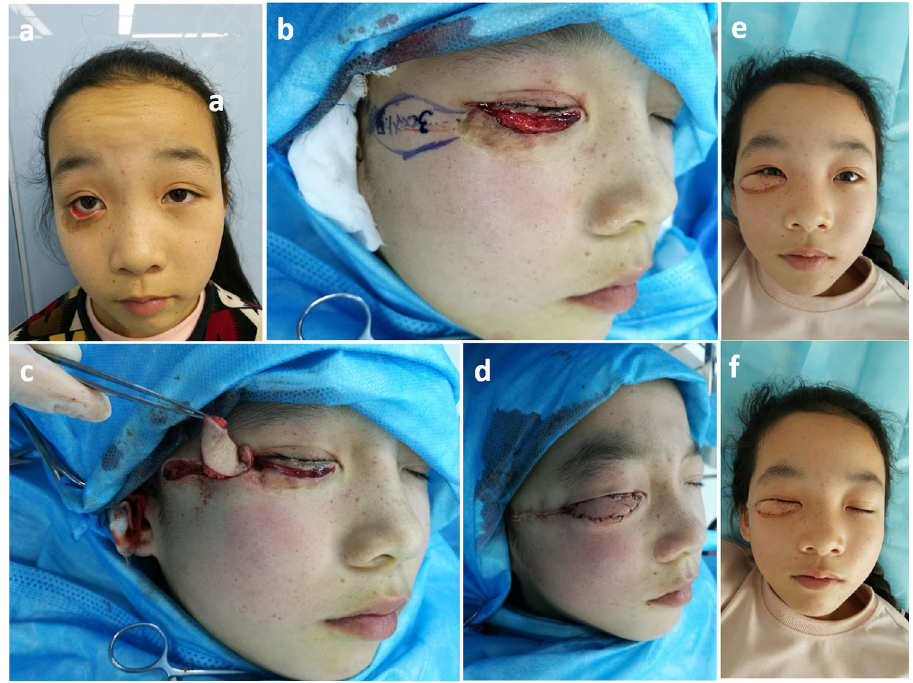
Figure 5. ( a , b ) A 5-year-old girl had a lower eyelid defect caused by a fall. After she was treated with skin grafting on the lower eyelid in the outer hospital, the skin contracture caused the lower eyelid ectropion. ( c , d ) We loosed the contracture of the tissue and designed the subcutaneous pedicled propeller flap to correct the defect. ( e , f ). The skin contracture and lower eyelid ectropion were successfully corrected and the wound healed